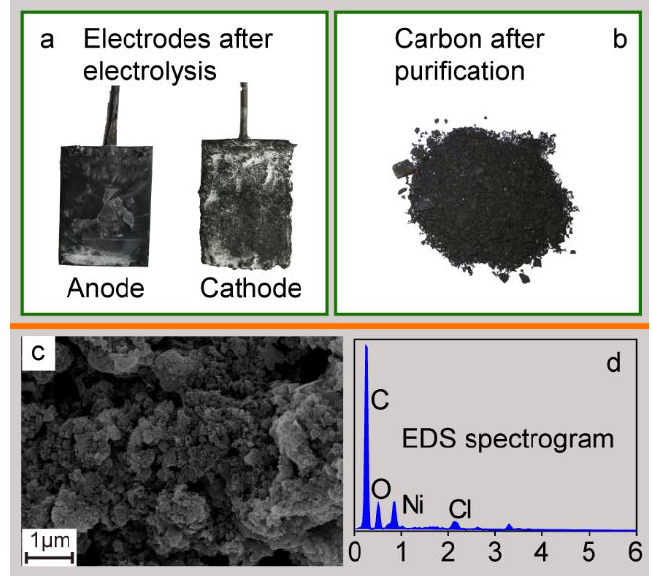
Figure 2. ( a ) Picture of Fe cathode surface after electrolysis; ( b )carbon products after purification; ( c ) SEM of carbon at 750 °C under 200 mA/cm 2 ; ( d ) EDS result of the obtained carbon product.